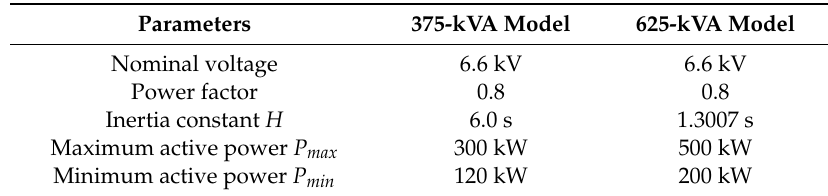
Table 3. Parameters of the diesel generators in “D” island.